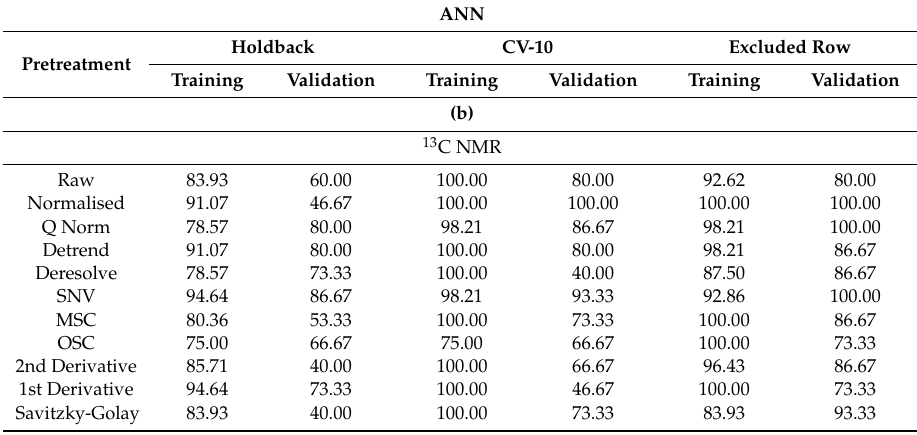
Table S1: The cultivars used in this study and their country of origin. Figure S1. The principle component analysis and loading plots for di ff erent 13 C NMR spectra. Figure S2. The principle component analysis biplots and loading plots for di ff erent 1 H zg30 NMR spectra. Figure S3. The principle component analysis biplots and loading plots for di ff erent 1 H NOESY NMR